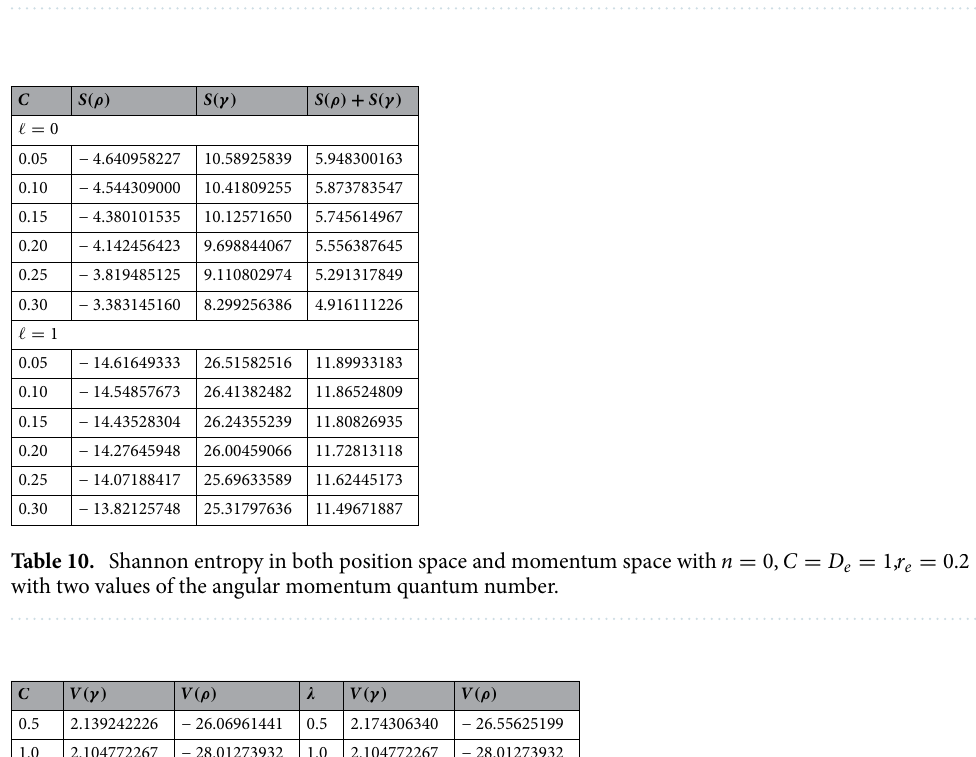
Table 9. Shannon entropy in momentum space of some diatomic molecules with n = ℓ = (cid:31) = 1.